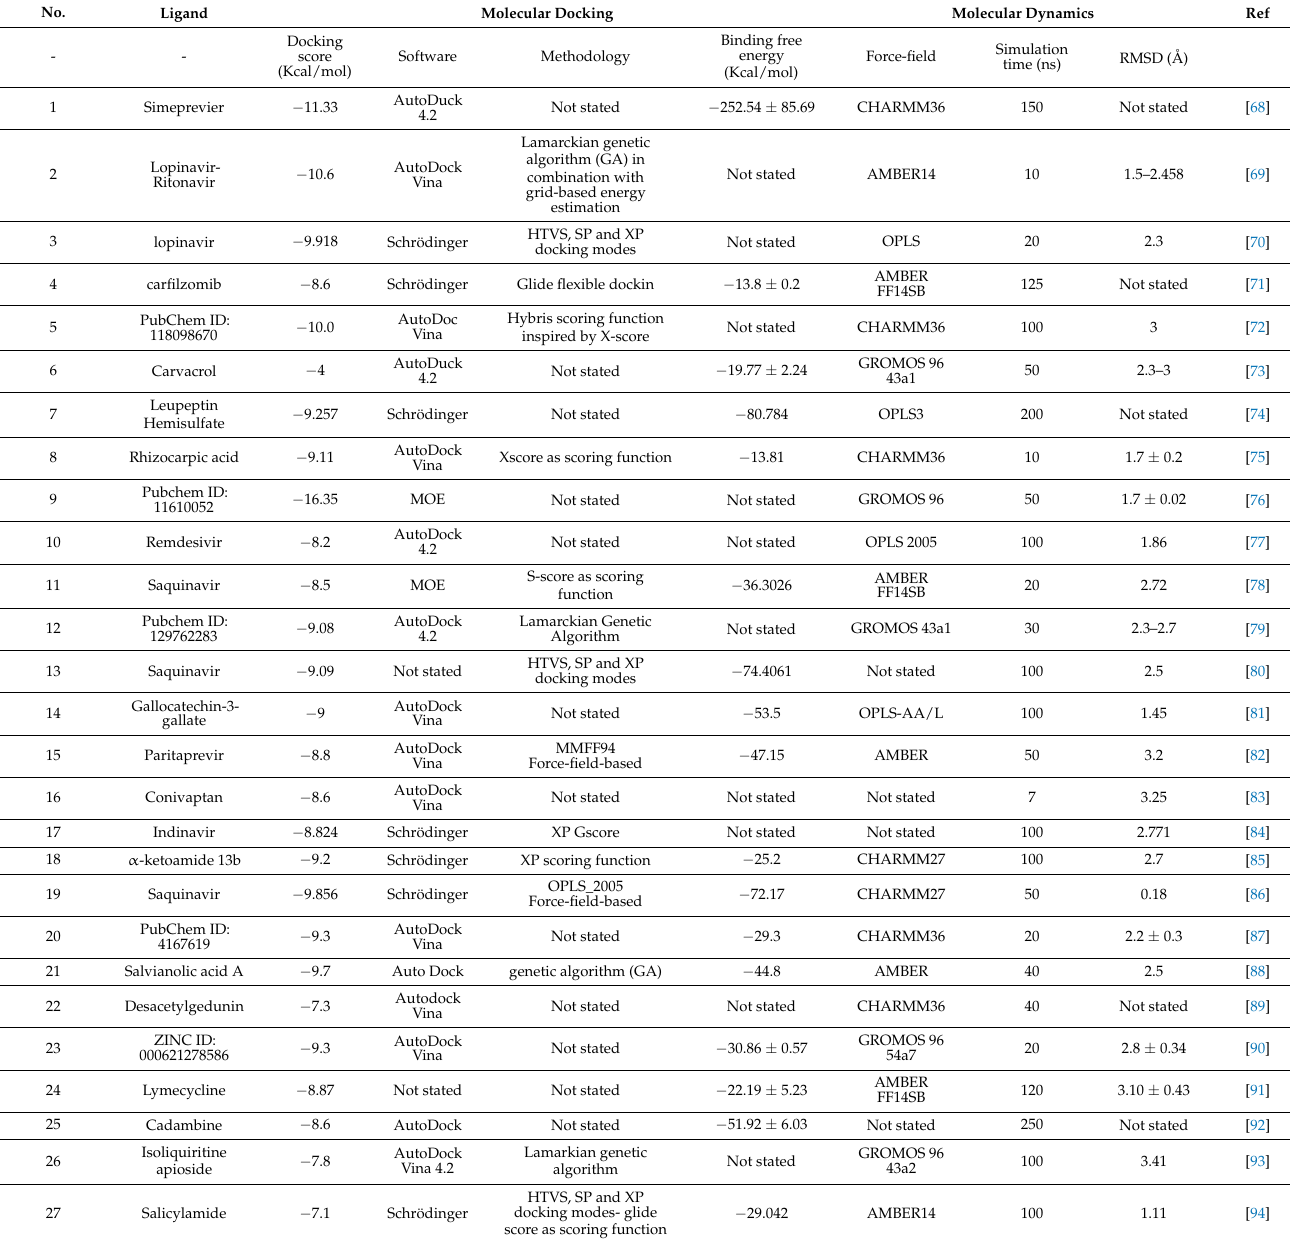
Table 1. Summary of viral protease targets using virtual screening to identify potential repurposed FDA-approved drugs and natural